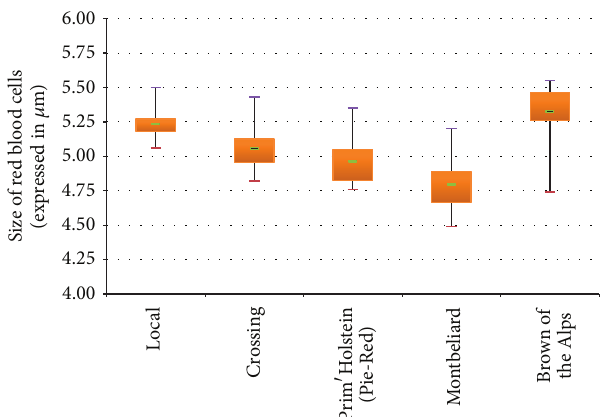
Figure 1: Influence of breed on the diameter of red blood cells in